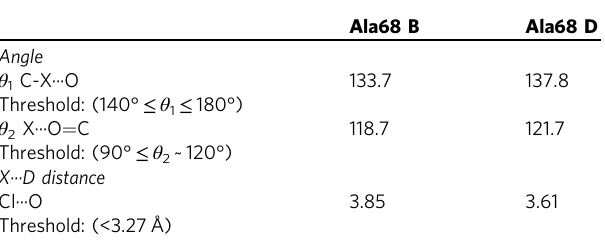
Table 2 Halogen bond parameters of compound 4 bound to DNA